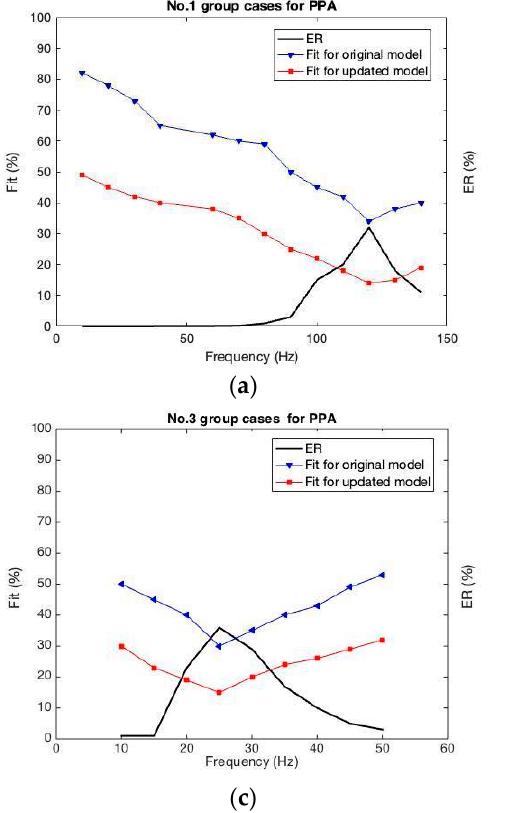
Figure 16. Error analysis of models with original and optimized parameters. ( a ) Error analysis for No. 1 group; ( b ) Error analysis for No. 2 group; ( c ) Error analysis for No. 3 group; ( d ) Error analysis for No. 4 group.